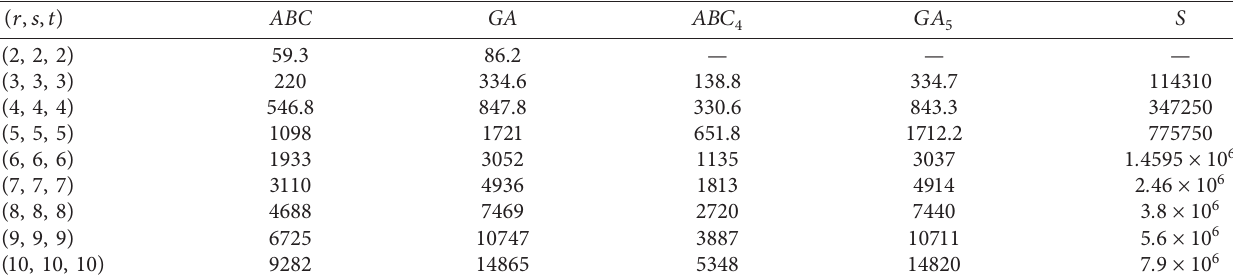
Table 5: Numerical comparison of indices of M [ r, s, t ] for some initial values of r , s , t ≥ 2.